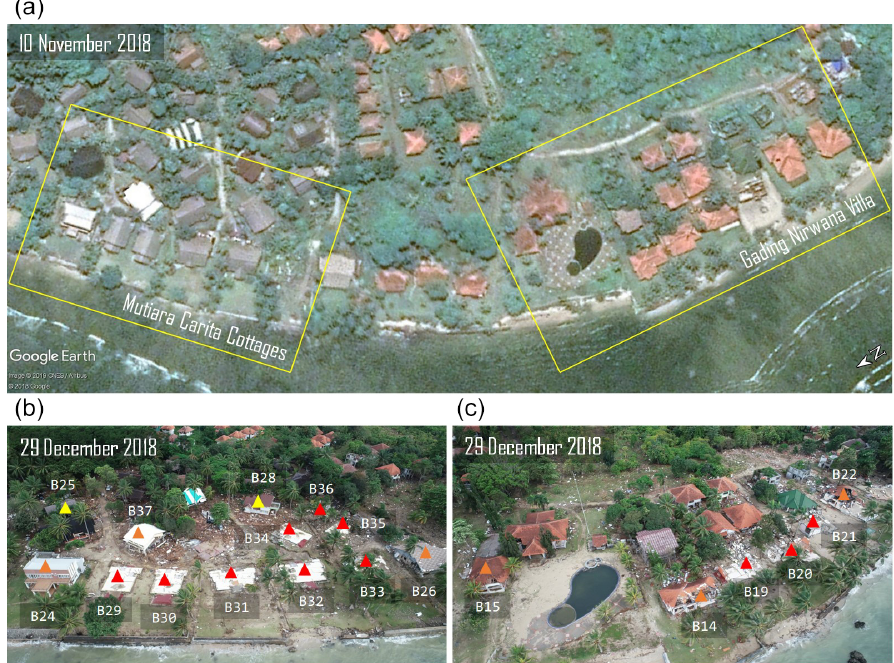
Figure 6. Aerial view of land destruction at Mutiara Carita Cottages and Gading Nirwana Villa, Banten. Panel (a) was adapted from Google